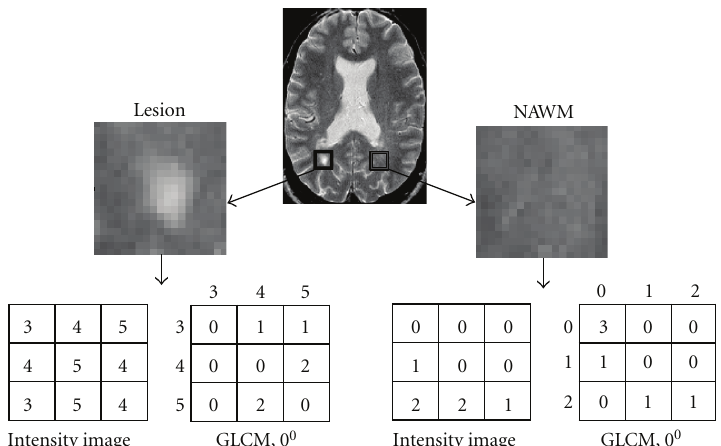
Figure 2: Schematic demonstration of texture analysis in the T2-weighted MR image from an MS patient (top) using a statistical method (gray-level cooccurrence matrix, GLCM). Areas of a focal lesion (box in the right) and the contralateral NAWM are delineated respectively, where texture analysis is conducted. Shown are di ff erent GLCMs computed at 0 degree based on the small sample subregions from the lesion (bottom right) and the NAWM of the